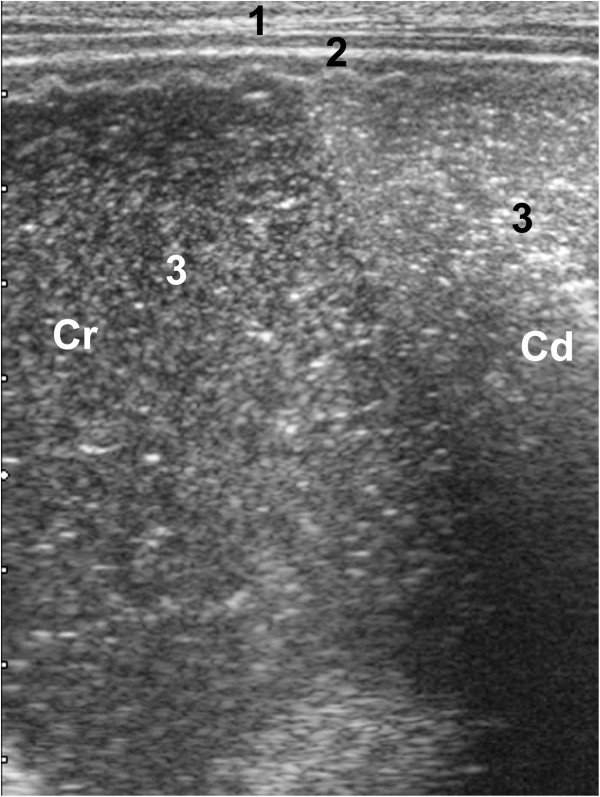
Ultrasonogram of the ventral sac of the rumen. Ultrasonogram of the ventral sac of the rumen of a 27-day-old Swiss Braunvieh calf with ruminal drinking syndrome. The 5.0-MHz linear transducer was held parallel to the ventral midline in the left lower abdominal area. The ruminal content appears heterogeneous and echoic. The undulating line medial to the ruminal wall indicates hyperkeratosis. 1 Ventral abdominal wall, 2 Ruminal wall, 3 Ruminal content, Cr Cranial, Cd Caudal.